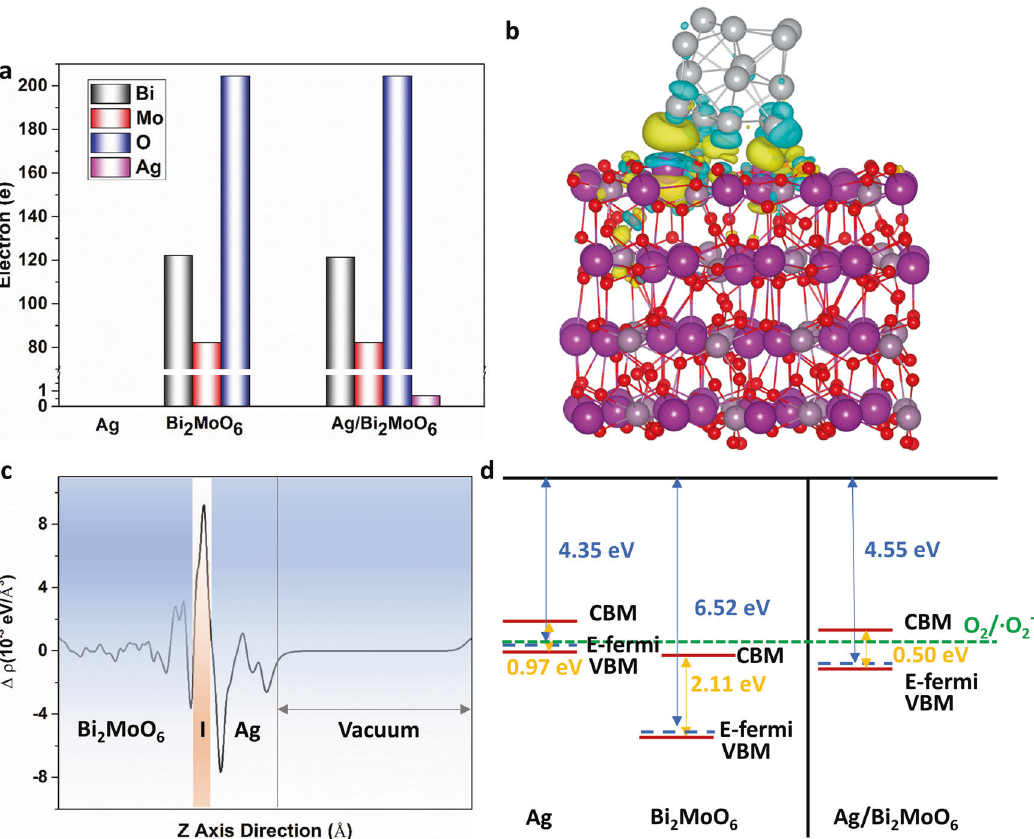
Fig. 2 Density functional theory theoretical calculations of Ag/BMO nanozyme. a Bader charge of Ag, BMO, and Ag/BMO. b , c Differential charge density and plane-averaged electron density difference along the z -axis of Ag/BMO. The isosurface is 0.002 eV/Å 3 . The yellow and gray color represents gain and lost electrons, respectively. d CB and VB con fi gurations of Ag, BMO, and